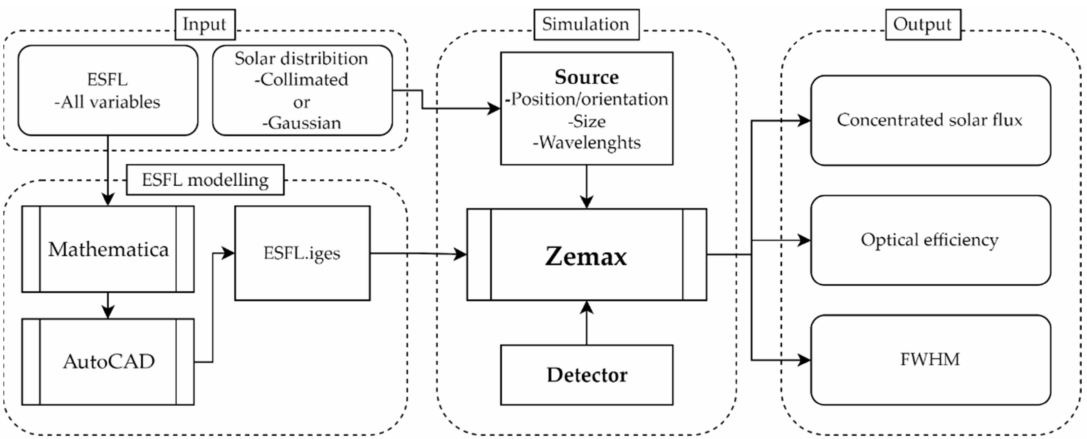
Figure 6. Sequence diagram of a single numerical